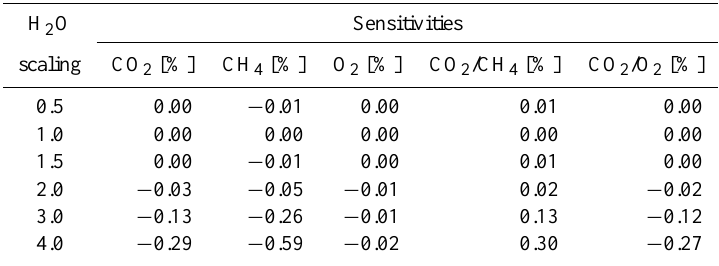
Table 8. Sensitivity of total column concentrations and their ratios to water vapour for a solar zenith angle (SZA) of 40 ◦ and an aircraft altitude of 1.25km. The H 2 O scaling factors denote the scaling of the background water vapour profile e.g. due to emissions of water vapour from a power plant’s cooling towers. H 2 O